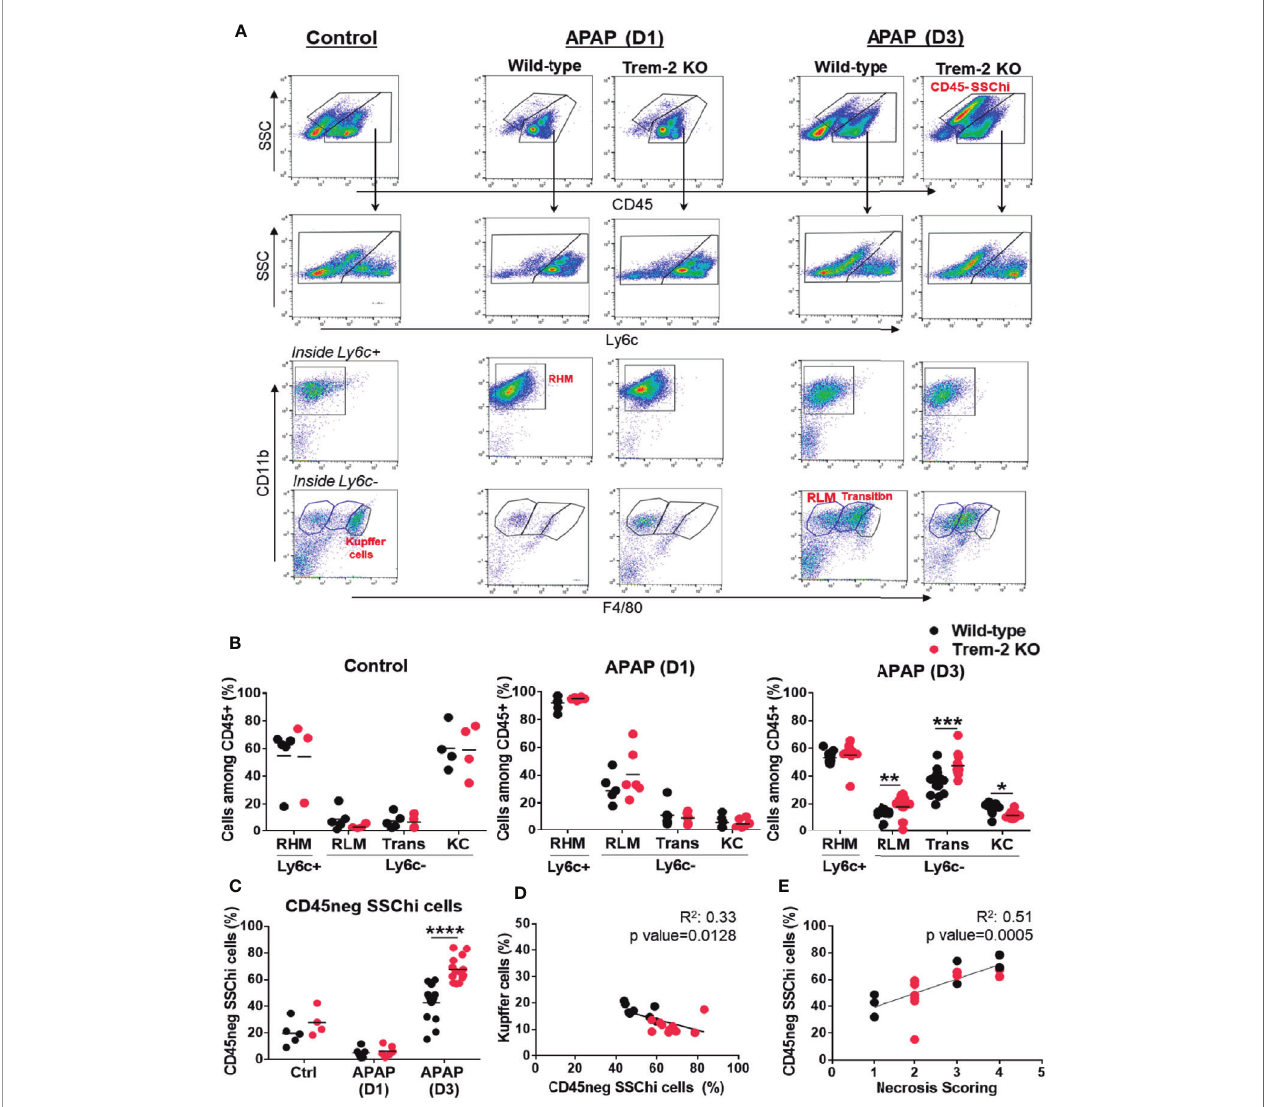
FIGURE 2 | Impaired KC replenishment upon acute liver injury in Trem-2 KO mice and accumulation of non-hematopoietic CD45neg SSChi cells. Flow cytometry analysis of liver non-parenchymal cells (NPCs) from wild-type and Trem-2 KO mice (control versus D1 versus D3) revealed distinct macrophage populations and a non-hematopoietic cell population (CD45neg SSChi). Among macrophages we identi fi ed Ly6c+ recruited hepatic macrophages (RHM, CD45+ Ly6c+ F4/80low CD11b+) and Ly6c- macrophages, namely, Kupffer cells (KC, CD45+ Ly6c- F4/80high CD11bint); transition macrophages (Trans, CD45+ Ly6c- F4/80int CD11bhigh); and recruited-like macrophages (RLM, CD45+ Ly6c- F4/80low CD11b+) (A) . Cell frequencies of macrophage populations (B) and non-hematopoietic CD45neg SSChi population (C) in control, APAP-D1 and APAP-D3 wild-type and Trem-2 KO mice. Inverse correlation of KC frequency with CD45neg SSChi population at APAP-D3 (D) . Correlation of CD45neg SSChi cells frequency with necrosis scoring at APAP-D3 (E) . Symbols represent values from individual mice (n=6-11 mice/group). Group mean values are presented. Statistics: Two-way ANOVA in (B , C) Pearson ’ s correlation test in (D , E) *, p<0.05 **, p<0.01 ***, p<0.001 ****,